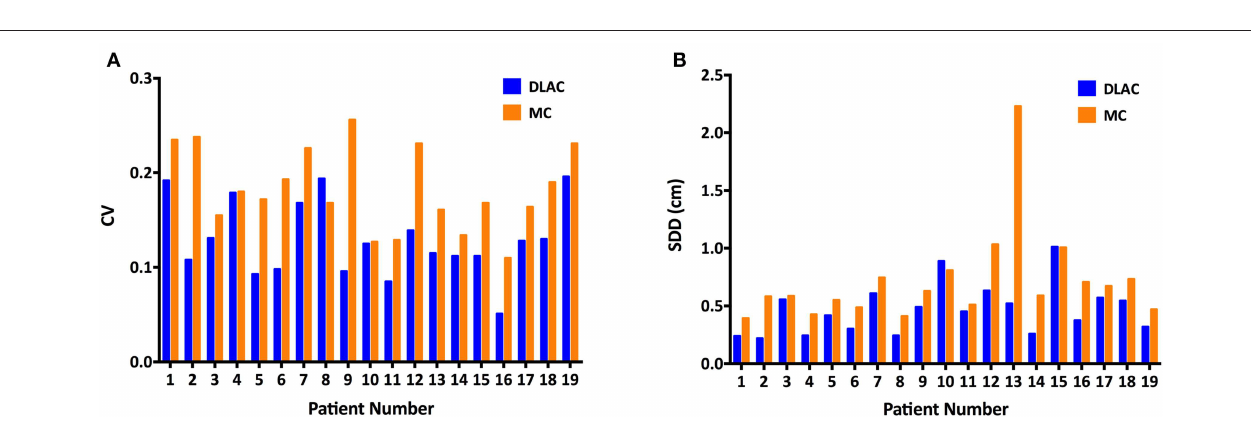
FIGURE 4 | (A) Coefficient of variation (CV) of the clinical target volume and (B) Standard distance deviation (SDD) of centroids for each patient with the DLAC (blue bars) and MC method (yellow bars). DLAC, deep learning-assisted contour; MC, manual